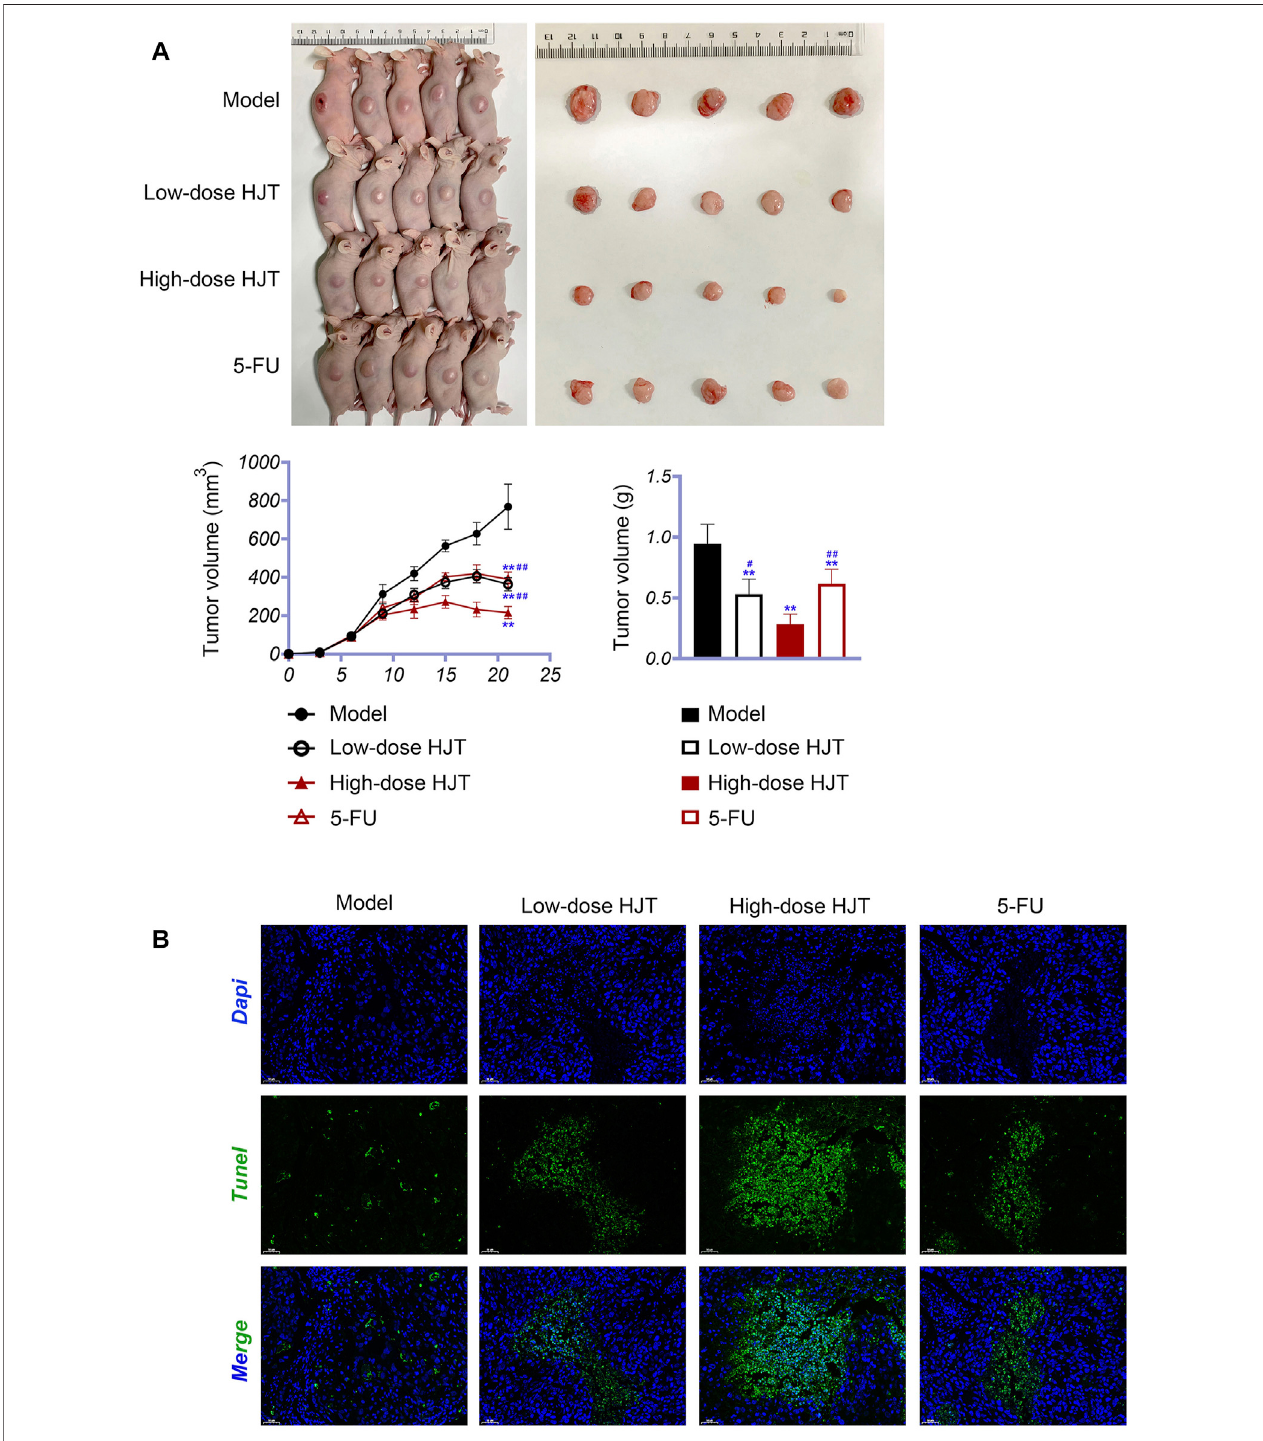
FIGURE 6 | HJT suppressed tumor growth. (A) Human GC cells (MGC-803) were inoculated subcutaneously on the right side of nude mice. Thereafter, tumors wereobservedinthecontrol, low-dose HJT(0.66 g/ml gavage), high-doseHJT (1.32 g/ml gavage),and positivecontrol(5-FU,20 mg/kg ip .)groups. Thetumor volume was calculated every 3 days, with only one measurement performed. After 15 days, mice were killed, and the tumors were isolated and weighed. (B) The apoptosis of tumor tissues in all four groups was detected using the TUNEL assay, scale bar = 50 μ m ** p < 0.01 vs . Control group. # p < 0.05 and ## p < 0.01 vs . High-dose HJT